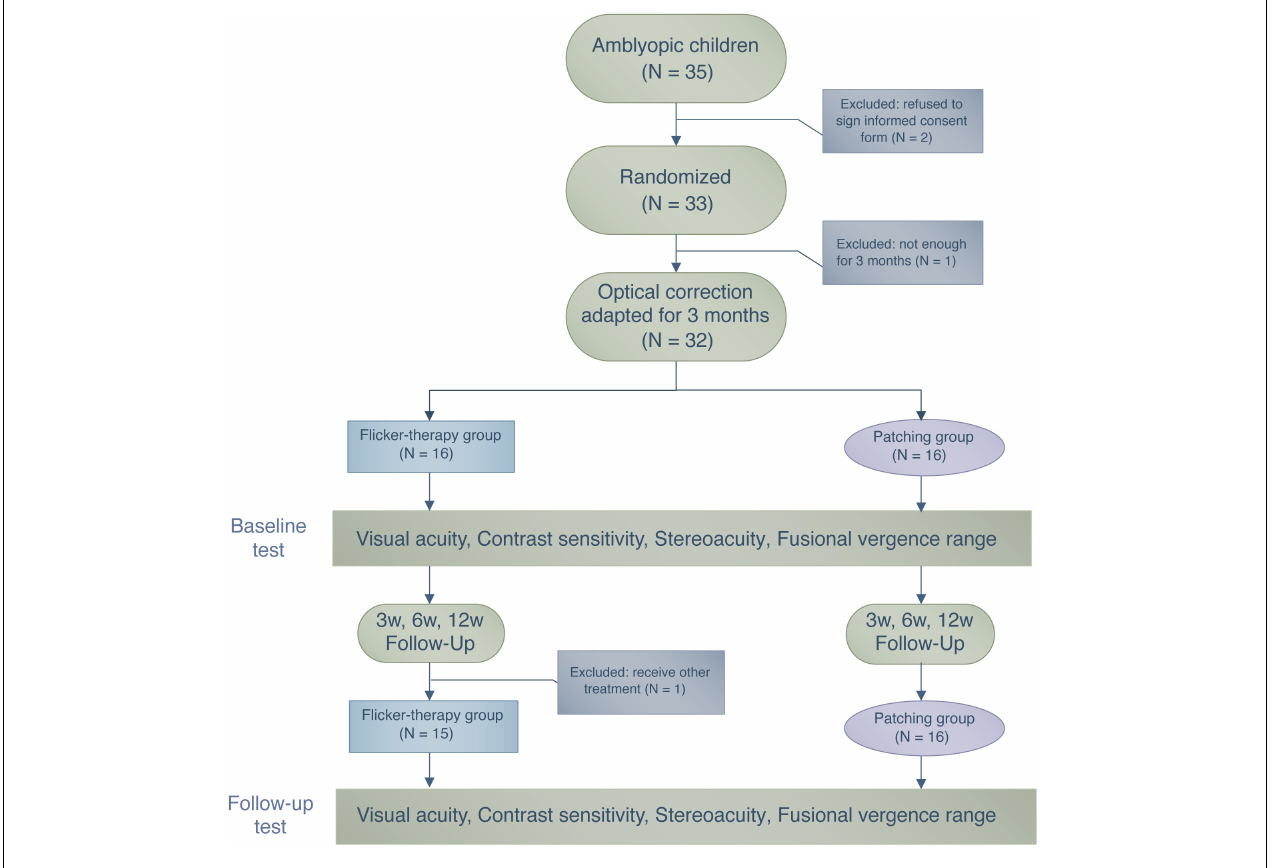
FIGURE 1 | A flowchart illustrating the treatment procedure and the number of patients who participated in this study.